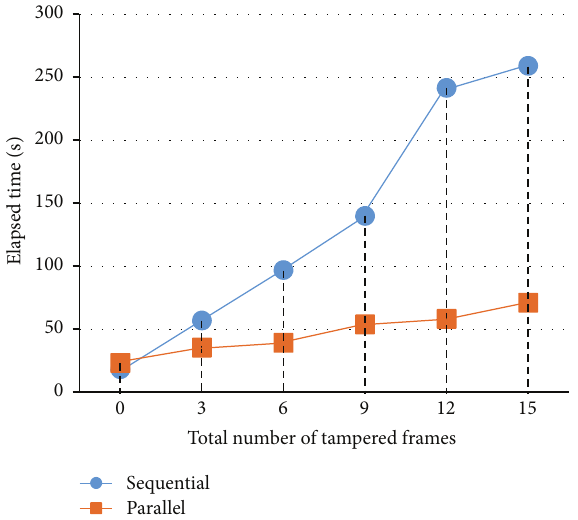
Figure 15: Comparison of elapsed time between sequential and parallel watermarking authentication process on different number of tampered frames.